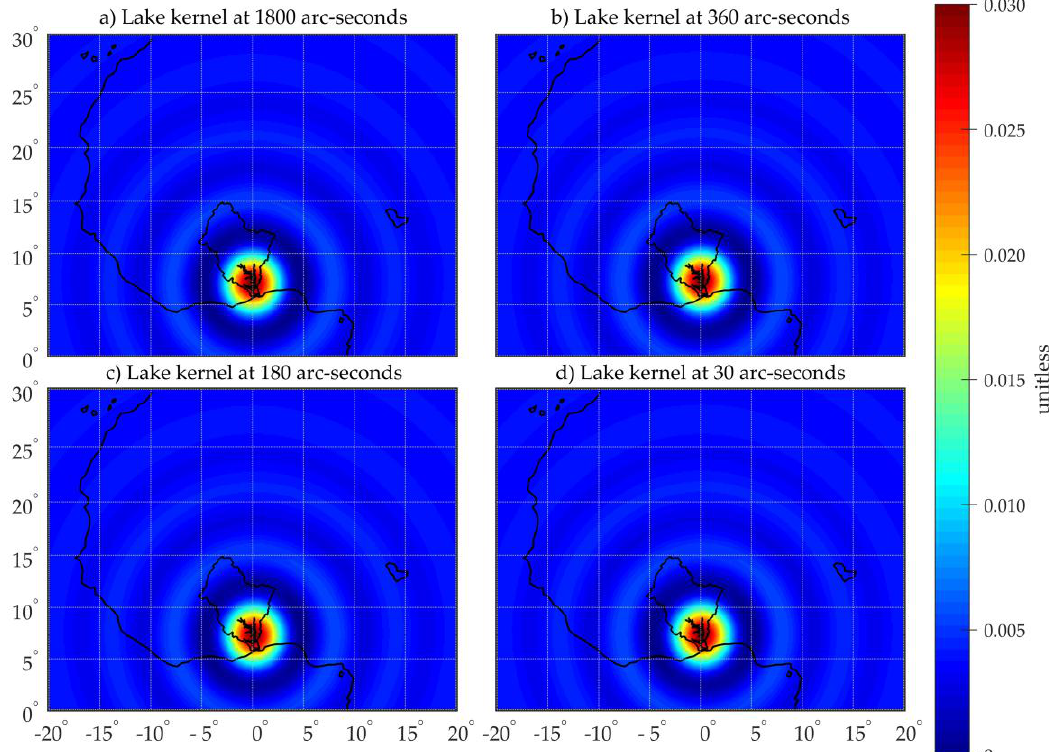
Figure 3. Kernel function for Lake Volta computed from spherical harmonic coefficients analyzed with different resolutions; that is, spherical harmonic coefficients computed using a global grid of ones within the lake and zeros elsewhere (see Equation (2)) at a resolution of 0.5 arc-degree ( a ), 0.1 arc-degree ( b ), 0.05 arc-degree ( c ), and 0.00833 arc-degree ( d ).